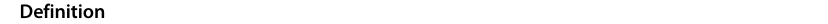
Table 1 The Clavien-Dindo classification